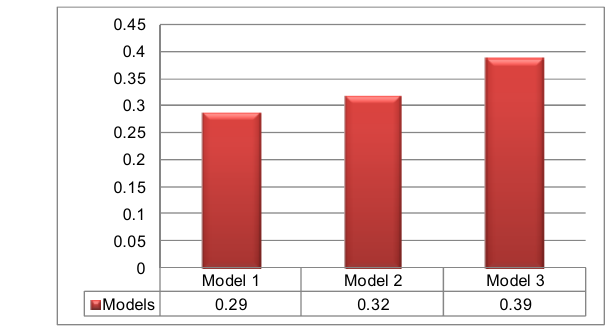
Figure 7 – Graphic representation of the final decision Pu с . 7 – Графическое изображение окончательного решения Слика 7 – Графички приказ коначне